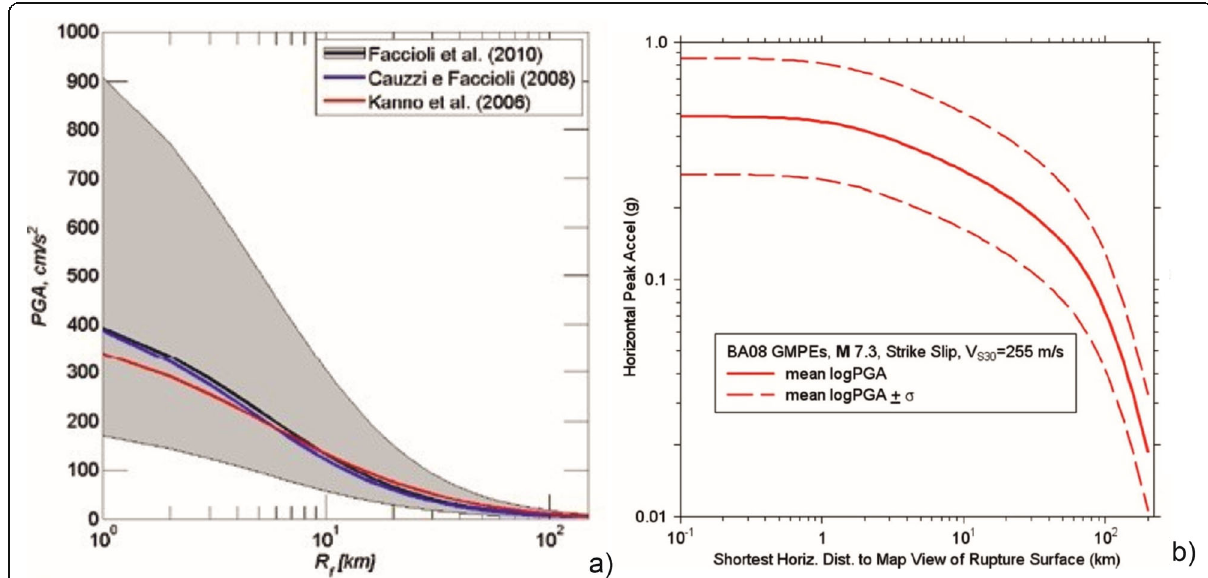
Fig. 3 a Ground Motion Prediction Equation (GMPE) of PGA versus the minimum source-to-site distance (After Faccioli 2012, modified): a band of uncertainty (grey) of GMPEs proposed by Faccioli et al. (2010). b 2008 Boore and Atkinson ground motion prediction equation (BA08 GMPE) of PGA based on data collected in United States for Magnitude 7.3 M w , strike-slip fault type and V S30 equal to 255 m/s: solid line is the mean equation; dashed lines represent the confidence interval at one standard deviation (After Boore 2013,